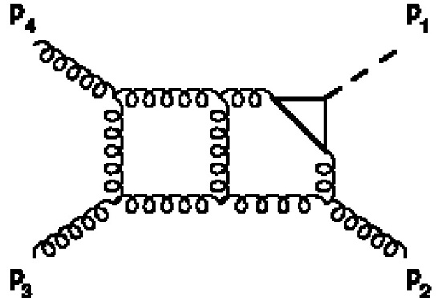
Figure 21. Planar three-loop diagram contributing to H + j